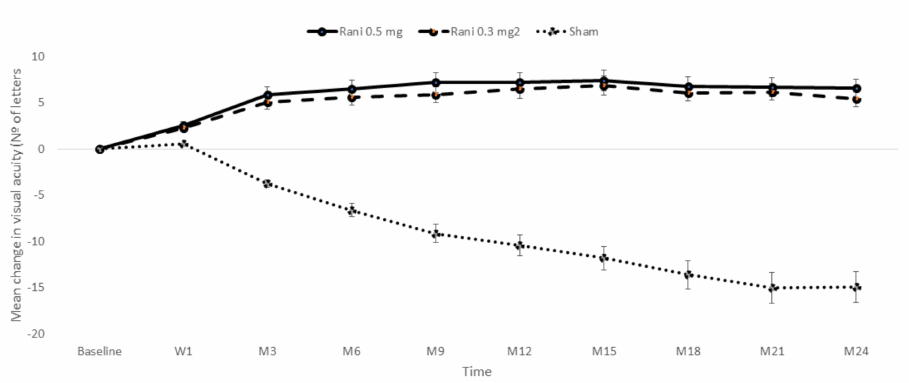
Figure 3. Mean ( ± SE) changes in the visual acuity from baseline through 12months observed in the ANCHOR study. As compared to the verteporfin group, the mean visual acuity was significantly greater in each of the ranibizumab groups at each month during the first year ( p < 0.001). Adapted from Brown et al. [90] and Brown et al. [93]. W: Week; M: Month. Rani: Ranibizumab; Beva: Bevacizumab.